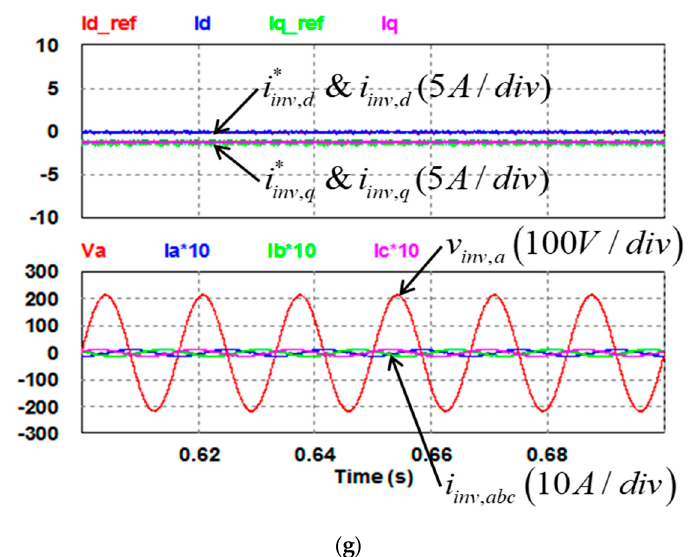
Figure 11. Detailed view of inverter dq-axis currents and their commands/phase A voltage (V) and three-phase currents (A) in Figure 10: ( a ) stage (1); ( b ) stage (2); ( c ) stage (3); ( d ) stage (4); ( e ) stage (5); ( f ) stage (6); ( g ) stage (7).